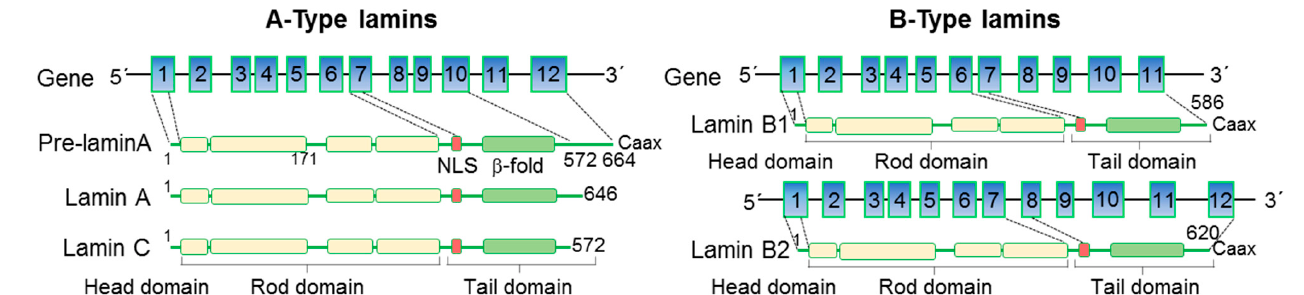
Figure 1. Structure of nuclear lamins. A- and B-type lamins have a conserved domain structure, consisting of a short N-terminal “head” domain, central helical coiled-coil rod domain, and a C- terminal immunoglobulin (Ig)-like β -fold domain. The nuclear localization signal (NLS) is located at the beginning of the tail domain. Pre-lamin A- and B-type lamins also have a CaaX motif at the C-terminus guiding their targeting to the inner nuclear